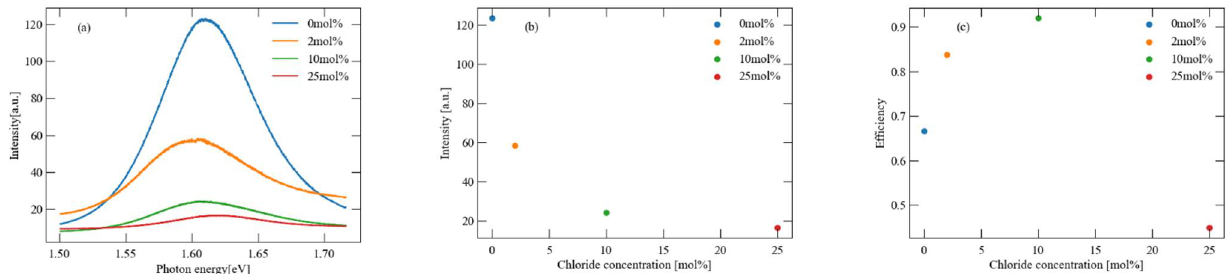
Figure 2. Integrated density of states in CH 3 NH 3 Pb(Cl,I) 3 as a function of Cl concentration.